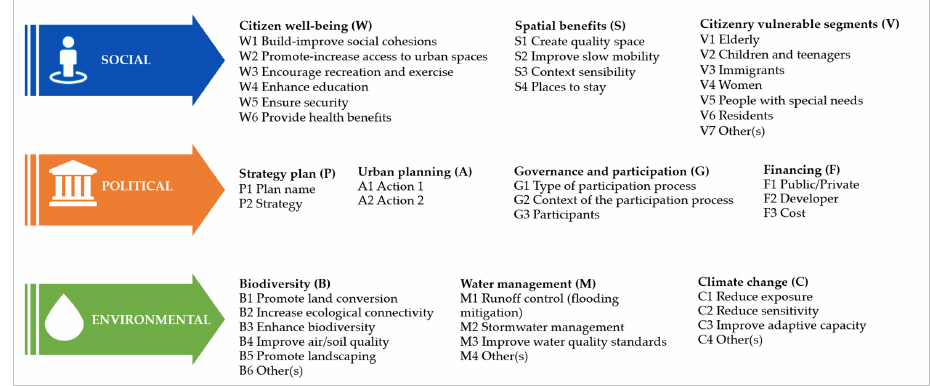
Figure 1. A triple-loop approach of urban resilience based on social, political and environmental dimensions. Source: Own elaboration from repositories mentioned in data collection plus secondary data and own reformulation.